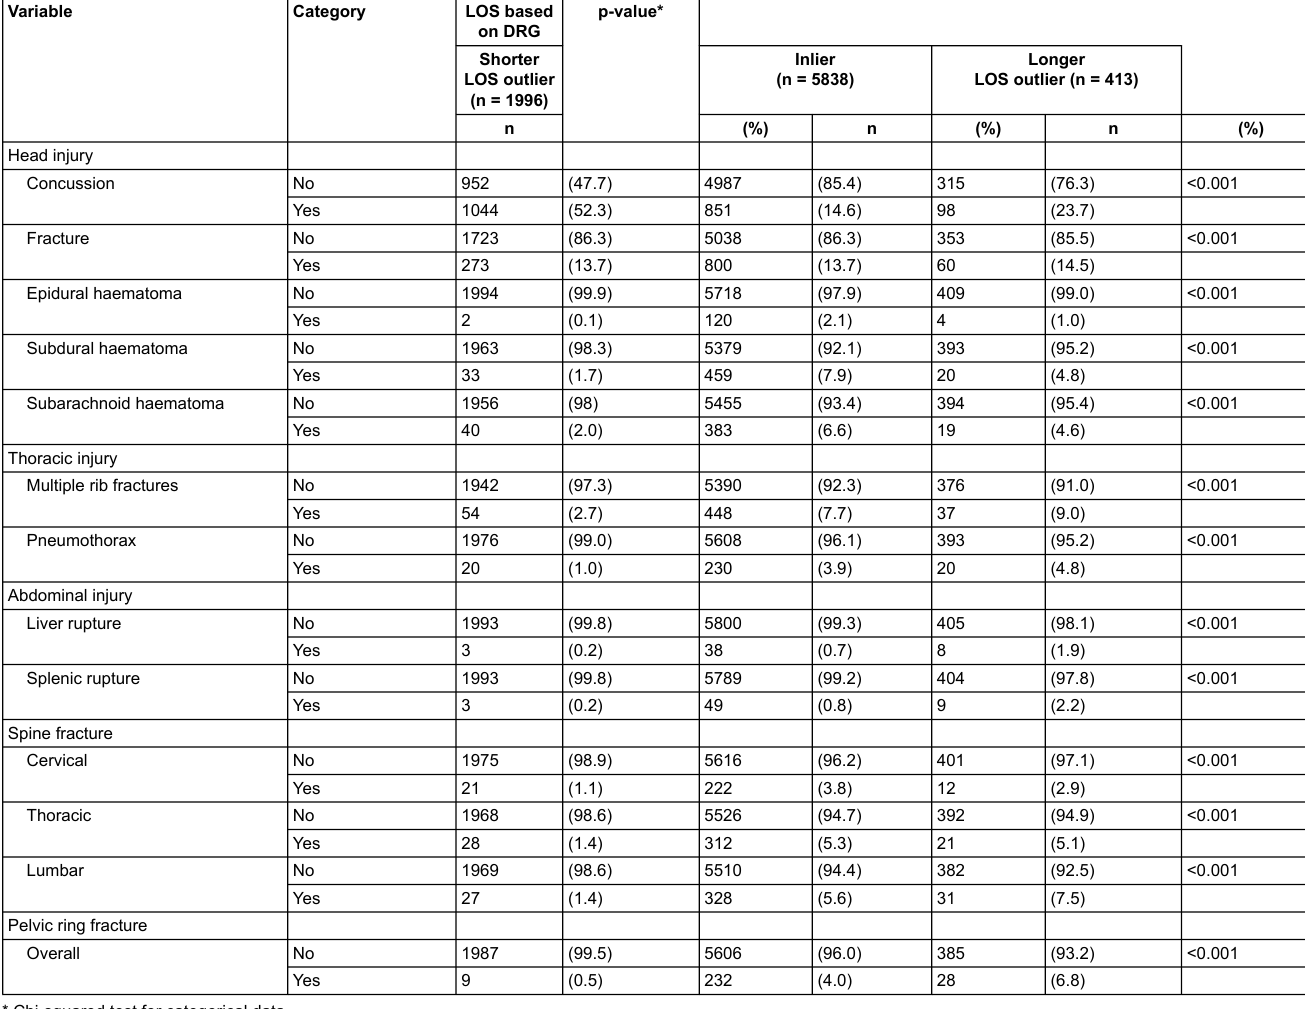
Table 2: Truncal injuries according to the length of hospital stay (LOS) based on diagnosis related group (DRG) (n = 8247).